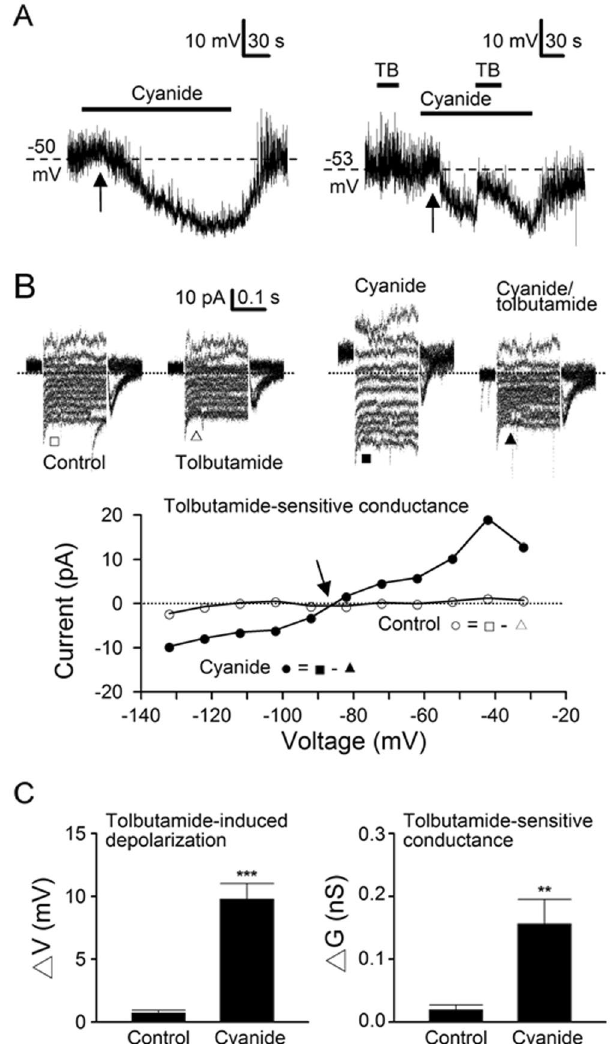
Figure 5. Cyanide inhibition of mitochondrial respiration activates K ATP channels. ( A ) A representative dSCN neurone showing the voltage responses to cyanide (left panel), and then again the tolbutamide (TB) effects on the membrane potential in control and in the presence of cyanide (right panel). Note the early depolarisations (marked by arrows) followed by tolbutamide-sensitive hyperpolarisation. Daytime recordings (ZT 4). ( B ) A representative dSCN neurone showing tolbutamide effects on the membrane currents in control (top left two panels) and then in the presence of cyanide (top right two panels). Bottom panel: the I-V relations of tolbutamide-sensitive conductance in control ( ○ ) and in the presence of cyanide ( ● ). Note the marked increase in the tolbutamide-sensitive conductance by cyanide. Daytime recordings (ZT 5). ( C ) Summary of tolbutamide- induced depolarisation (left panel) and tolbutamide-sensitive conductance (right panel) in control and in the presence of cyanide. TTX was present to block the action potentials. Baseline resting potential: − 55 ± 2 mV ( n = 16). Baseline resting conductance: 0.32 ± 0.03 nS ( n = 16). Dotted lines are zero current levels. ** P < 0.005, *** P <